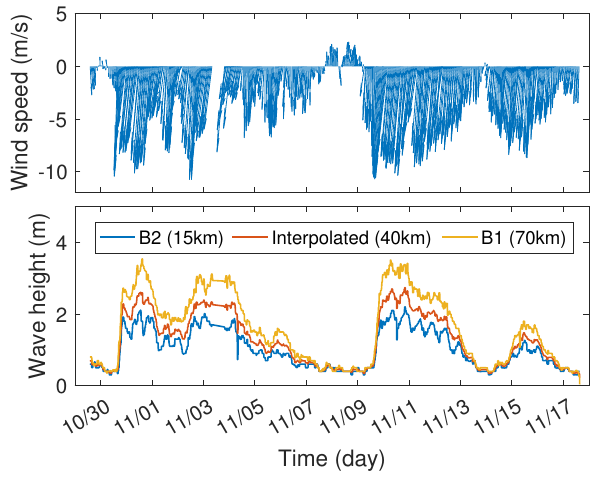
Figure 7. Wind ( top ) and wave height ( bottom ) data of buoys. The wind data is collected by buoy B2, and the wave height at the distance of 40 km is obtained by interpolating the data from B1 and